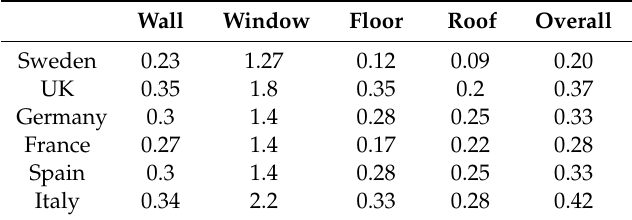
Table 5. U-values for of the building elements for the various countries (W / m 2